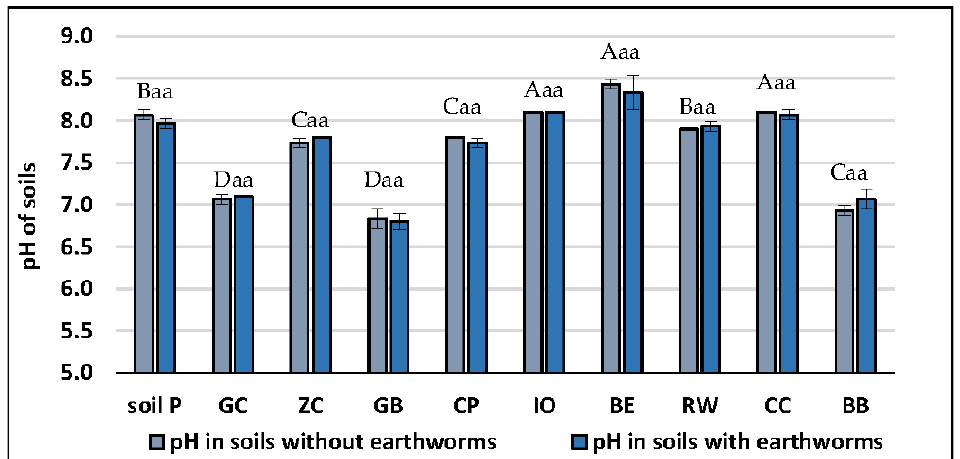
Figure 2. Influence of amendment application and earthworm activity on soil pH. Different lower case letters within the same type of amendment application indicate significant differences between pH in soils with and without earthworms, while capital letters indicate significant differences between applied amendments (ZC-Zabrze compost, GC-GWDA compost, BB- Bełchatów biosolids, GB-Grabów biosolids, CP-Calcium phosphate, IO-Iron oxide, BE-Bentonite, RW-Rock waste, CC-Limestone; ANOVA, Mann-Whitney test, p < 0.05).